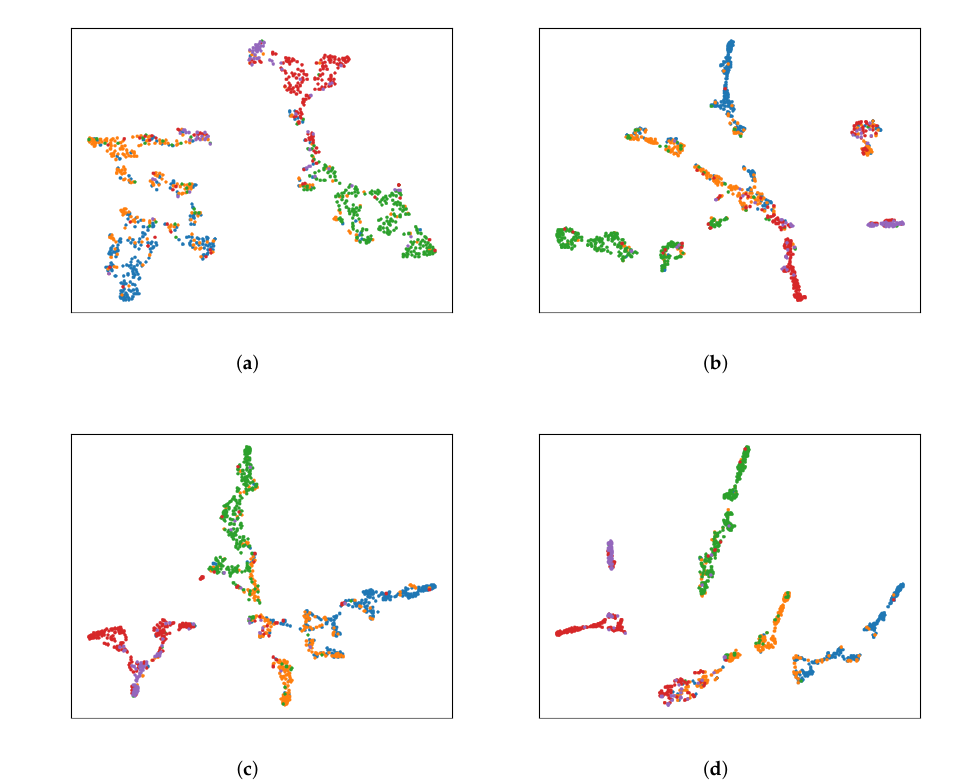
Figure 7. Visualization of test node embeddings of GCNII and GCNII-Motif on acmv9 and citationv1 by tSNE. xxx-Motif represents the GNNs integrated with our motif-based subgraph aggregation strategy. ( a ) GCN on citationv1; ( b ) GCN-Motif on citationv1; ( c ) GCNII on citationv1; ( d ) GCNII- Motif on